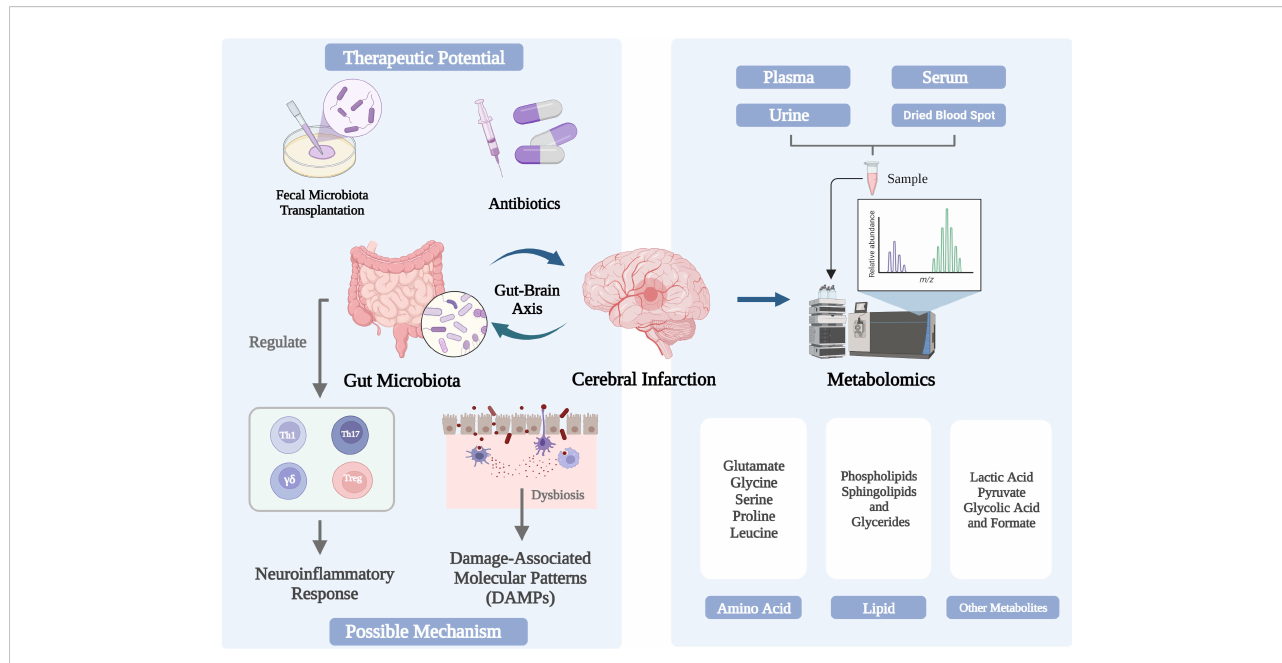
FIGURE 1 Changes and in the gut microbiome and metabolome associated with cerebral infarction and their triggering